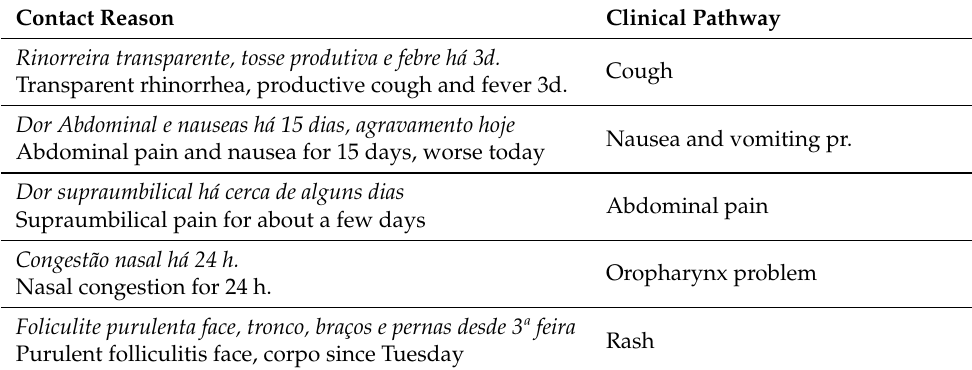
Table 1. One example of the “Contact Reason” for each of the 10 most common clinical pathways. Contact